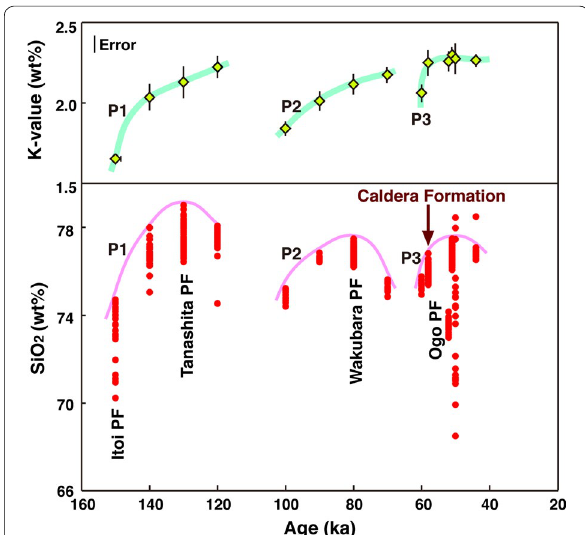
Fig. 10 Temporal variations of SiO 2 (red) and K-value (green) for volcanic glass in pumice of Akagi Volcano. K-value means abundance of K 2 O at SiO 2 75.0 wt%. Observed patterns of geochemical fluctua- = tion coincide with the sub-stages of P1, P2 and P3. The Ogo Pumice Flow eruption occurred at 60 ka and resulted in a summit-caldera formation. Modified from Yamamoto (2016)